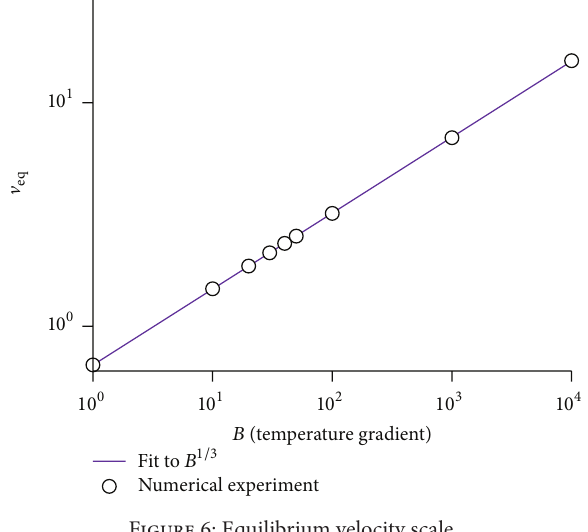
Figure 6: Equilibrium velocity scale. Table 1: Equilibrium values of velocity for different values of heat flux 𝐵 .